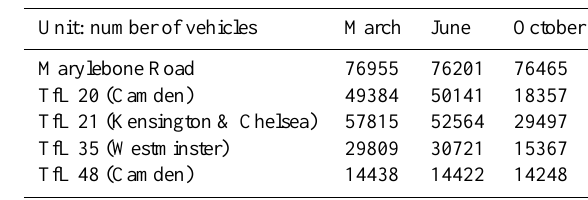
Table 2. Average daily traffic counts at Marylebone road and four Transport for London (TfL, with permission) sites in March, June and October